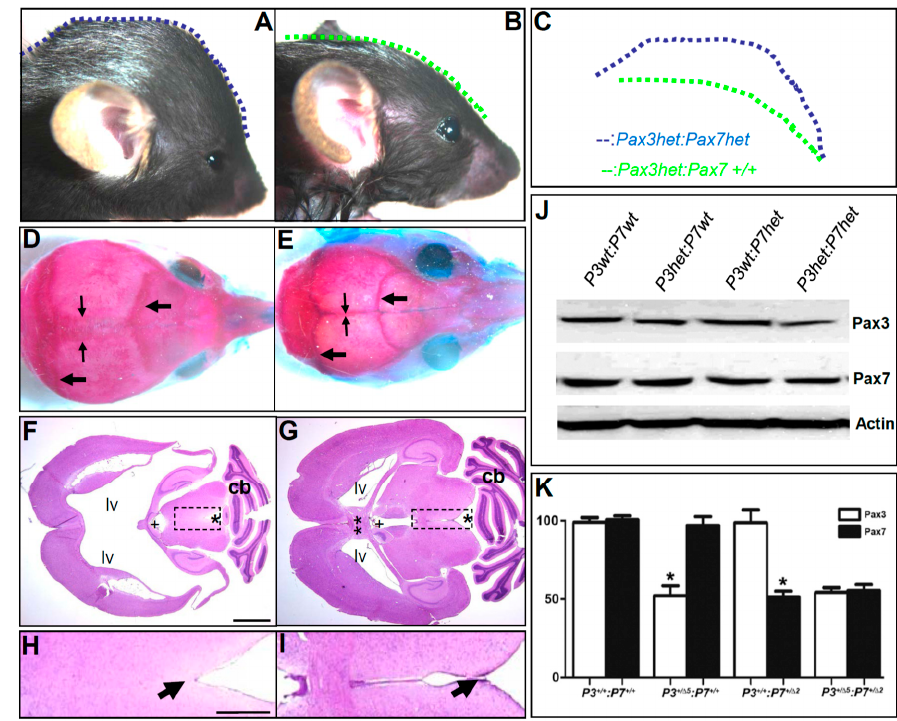
Figure 8. Pax3 and Pax7 play a combinatorial role in cerebral ventricular development. ( A – C ) Lateral views of Pax3 +/ Δ 5 /Pax7 +/ Δ 2 compound heterozygous mutant ( A ) and control ( B ) P20 littermates, with lateral profiles depicted by dotted lines and compared side-by-side to highlight the large domed cranium in Pax3 +/ − /Pax7 +/ − mutant ( C ); ( D , E ) Skeletal preps of heads from animals in ( A , B ); only the compound mutant ( D ) displays sagittal (narrow arrows) and transverse (thick arrows) suture fusion defects; ( F , G ) Hematoxylin and eosin sections reveal that the mutant lateral ventricle ( F ) is dilated and there is a loss of structure, when compared to control (double asterisks, G). The normal anterior segment of the third ventricle (plus sign), aqueduct (asterisk), and cerebellum (c,b) are indicated; ( H,I ) high power view of stenotic connection between mutant third ventricle and aqueduct (arrow, H), compared to normal third ventricle-aqueduct junction in control ( I ); ( J , K ) Results of representative Western blot analysis ( J ) and densitometric quantification ( K ) of Pax3 and Pax7 expression levels in individual E10.5 whole embryo lysates of designated genotypes ( n = 3–5 of each genotype were analyzed). Note the gene dosage-dependent reduction (~50%) of corresponding protein level in various heterozygous compound offspring, relative to wild-type ( P3 `{` /P7 `{` ). Data are represented as mean ˘ SEM, * p < 0.05 by Student’s t-test (Pax3 versus Pax7 in each genotype). Scale bars: F,G = 2 mm; H,I = 0.5